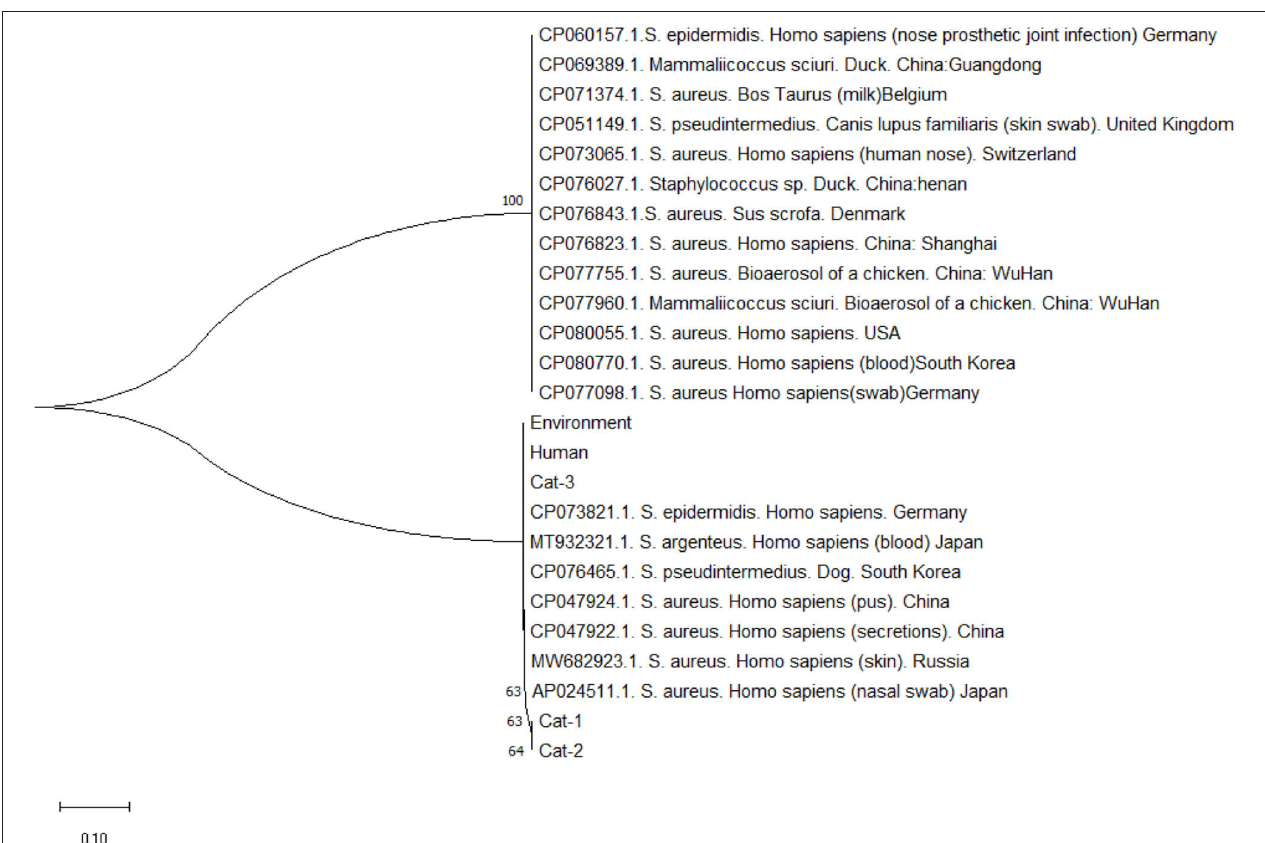
FIGURE 5 | Phylogenetic tree of Staphylococcus aureus mecA